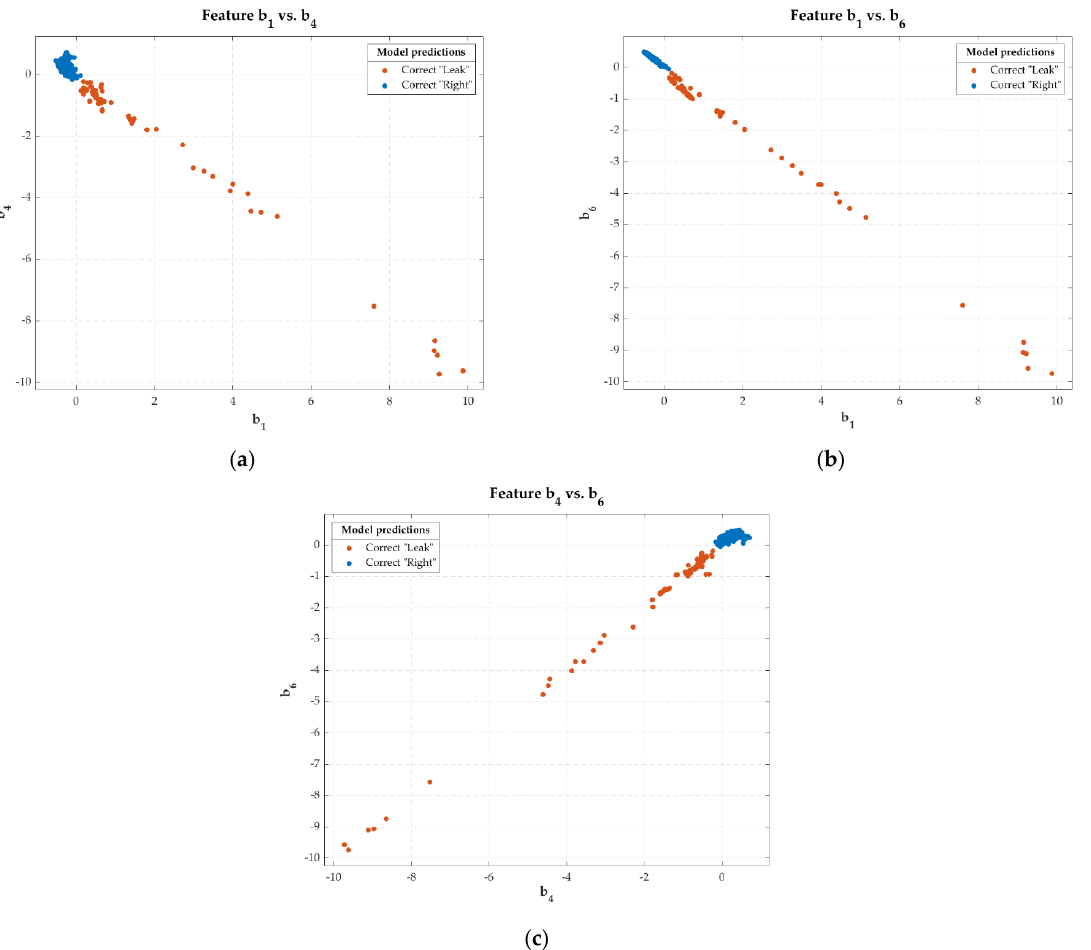
Figure 10. Scatter plots with the classification results of the predictive logistic regression model with the input features b 1 , b 4 , and b 6 : scatter plot of feature b 1 vs. b 4 ( a ); scatter plot of feature b 1 vs. b 6 ( b ); scatter plot of feature b 4 vs. b 6 ( c ) .